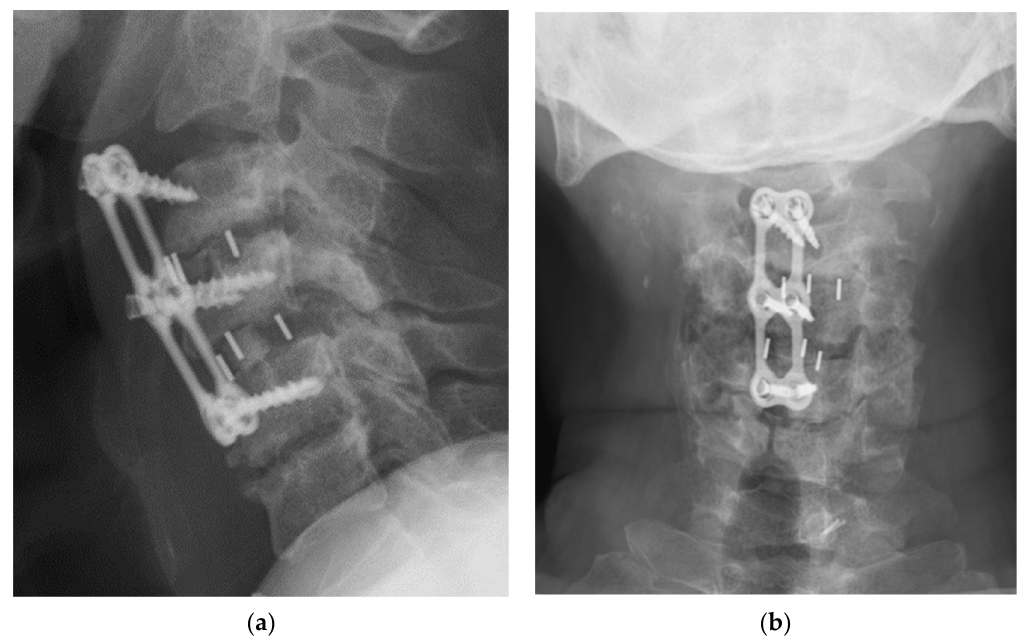
Figure 2. Radiograph after C3–4–5 ACDF surgery of a 50-year-old man with ESRD. ( a ) Lateral view and ( b ) anteroposterior view revealed implant dislocation with grade 4 fusion status at C3–4 and grade 3 at C4–5; grade 0 cage subsidence at both C3–4 and C4–5 levels without progression of neurological symptoms. ACDF, anterior cervical discectomy and fusion; ESRD, end-stage renal disease.